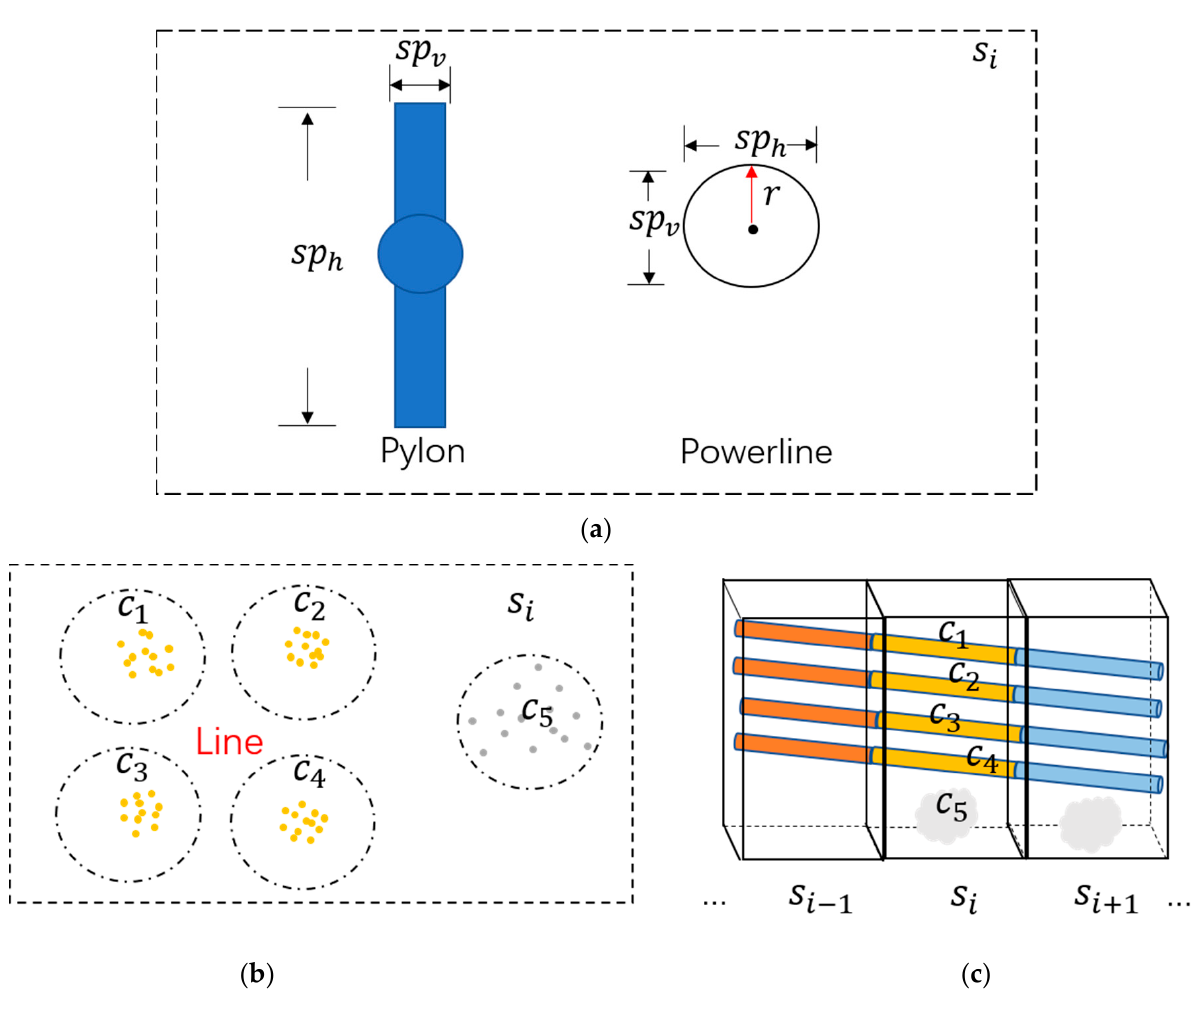
Figure 7. Powerline candidate selection. ( a ) Characteristic of rotated powerline and pylons. Black arrows denote the